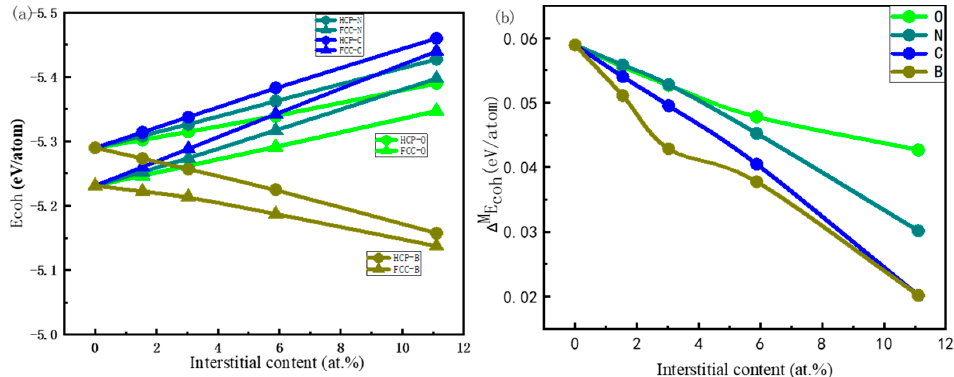
Figure 3. ( a ) The average cohesive energy ( M E ) varies with the content; ( b ) the relation between coh